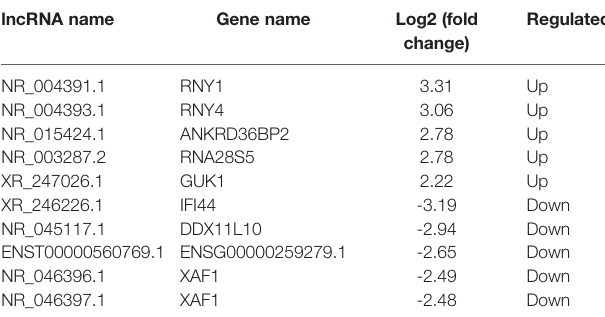
TABLE 4 | The top 10 differentially expressed lncRNAs.